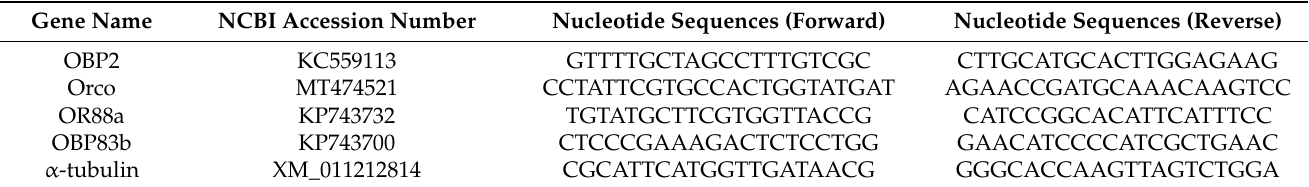
Table 1. Primers used for gene expression detection by